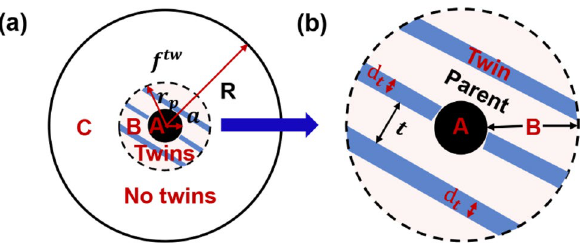
Figure 4. Schematic diagram of thermal mismatch induced twins in TMDT model. ( a ) A representative grain with three regions: spherical particle reinforcement (region A), plastic accommodating region (region B) and non-affected region (region C), where thermal mismatch induced nanoscale twins with volume fraction ( f tw ) existing in region B. ( b ) Enlarged region B shows average twin thickness ( d t ) and twin spacing ( t ),